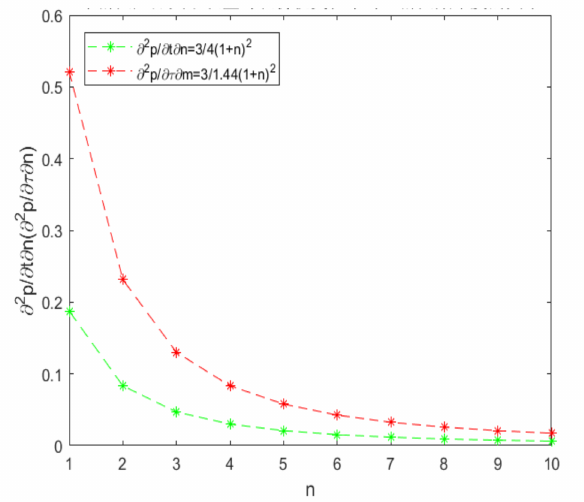
Figure 13. Relationship between rates of change for products in downstream countries with re- gard to rates of change for a specific duty and ad valorem tax and the degree of concentration in upstream countries.